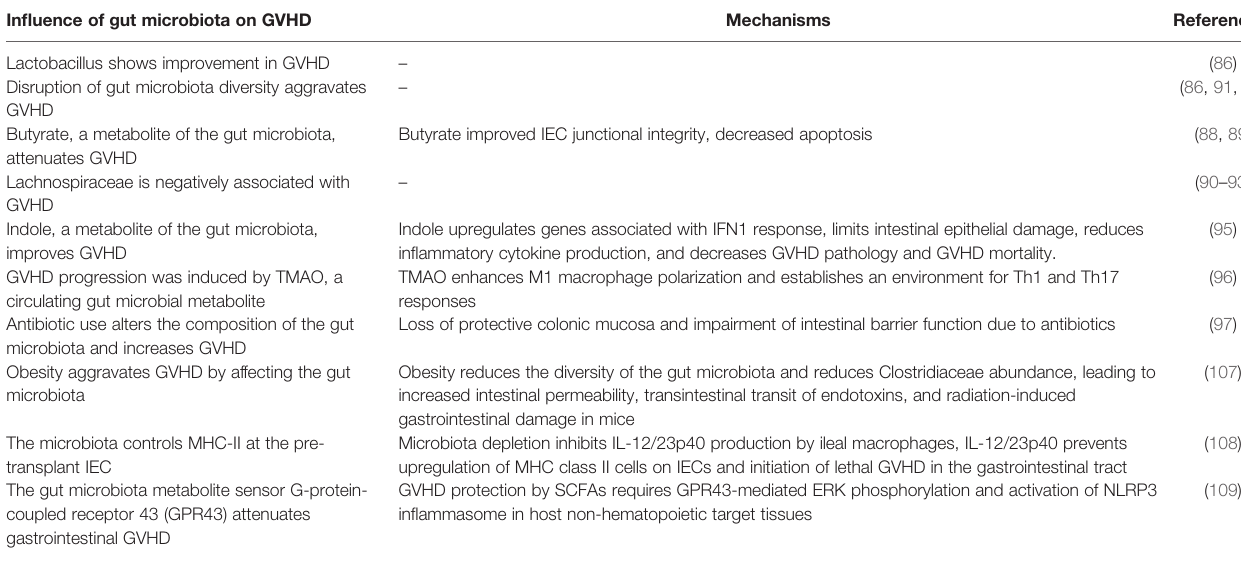
TABLE 1 | Mechanisms by which the gut microbiota affects